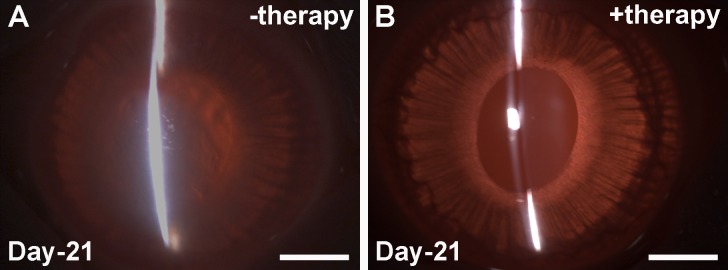
Slit-lamp images at day 21 after administration of PEI2-GNP only (A) and of PEI2-GNP–mediated BMP7+HGF (B), showing persistence of haze in the −therapy eye and a clear cornea after BMP7+HGF. Scale bar: 2 mm.